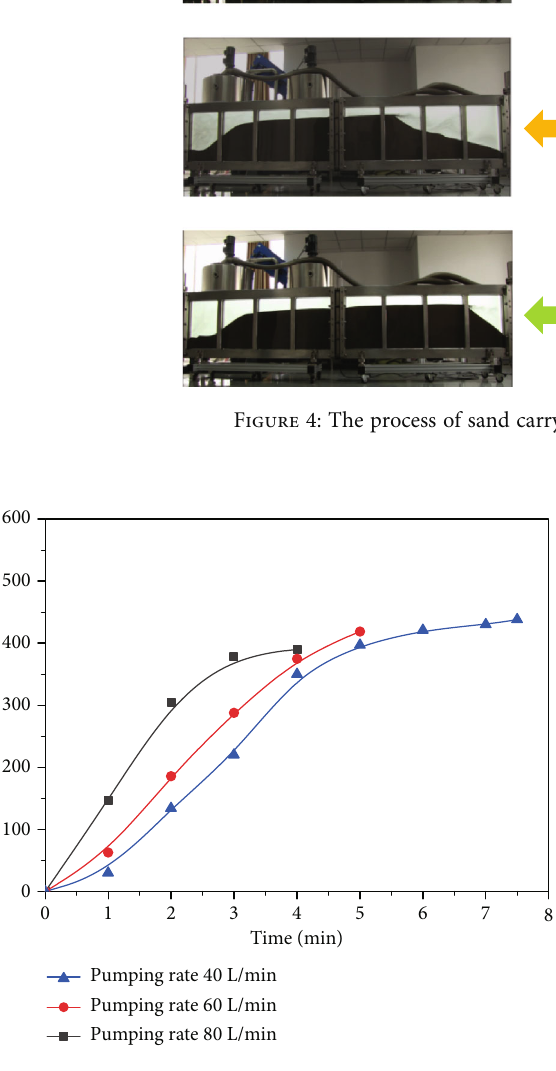
Figure 5: The height of the sand dike in sand carrying by slickwater with di ff erent pumping